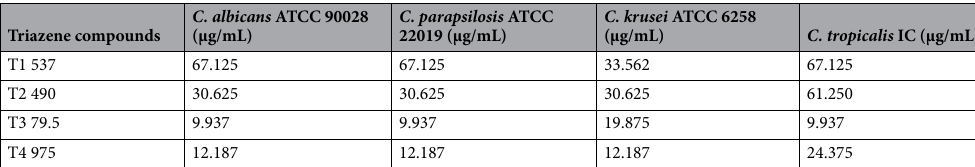
Table 5. MIC of triazene compounds against ATCC standard yeasts and clinical isolates (CI).